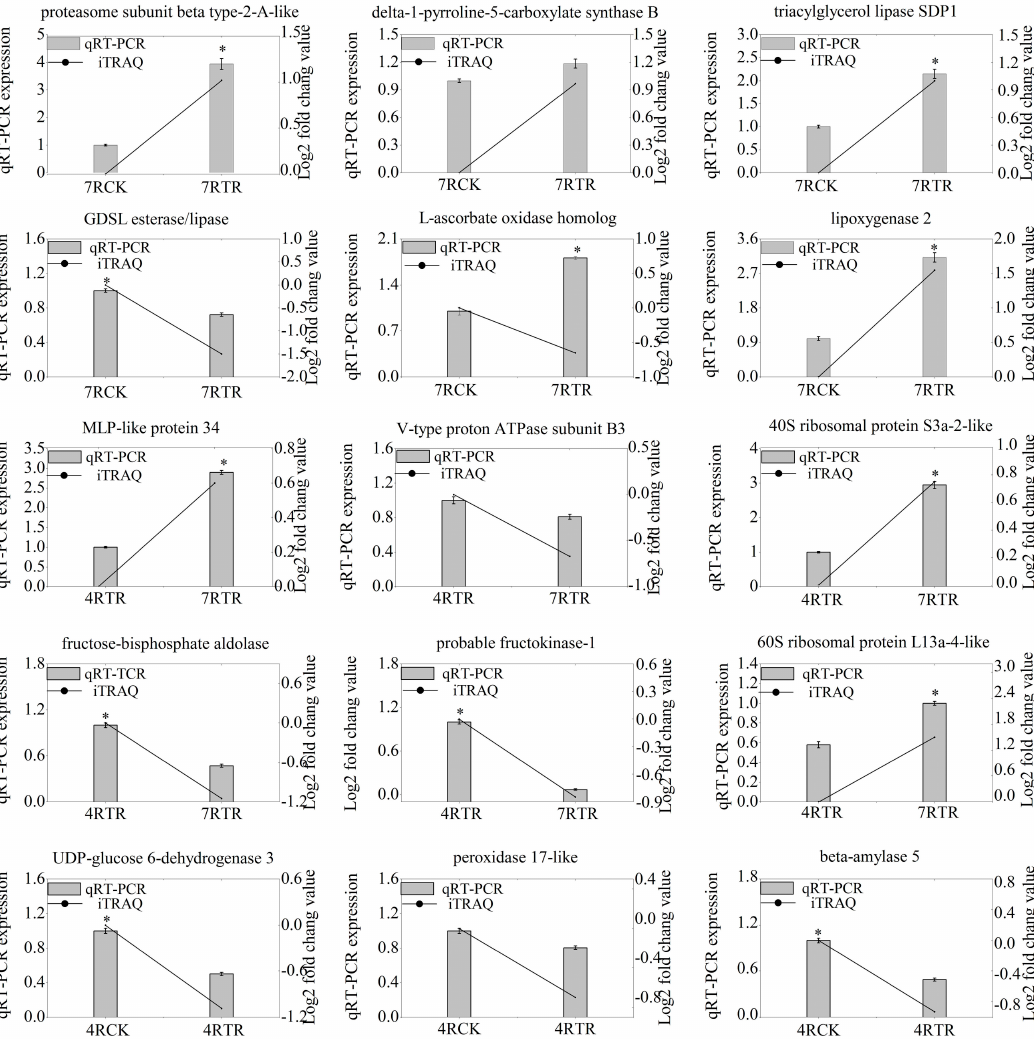
Figure 8. Analysis of the transcript levels of DAPs by a quantitative real-time polymerase chain reaction (qRT-PCR). The candidate genes were from differential protein genes between 7RTR and 7RCK, between 7RTR and 4RTR, and between 4RTR and 4RCK. Statistically significant differences (Duncan’s multiple range tests, * p < 0.05) of transcription analysis by qRT-PCR are indicated by asterisks.